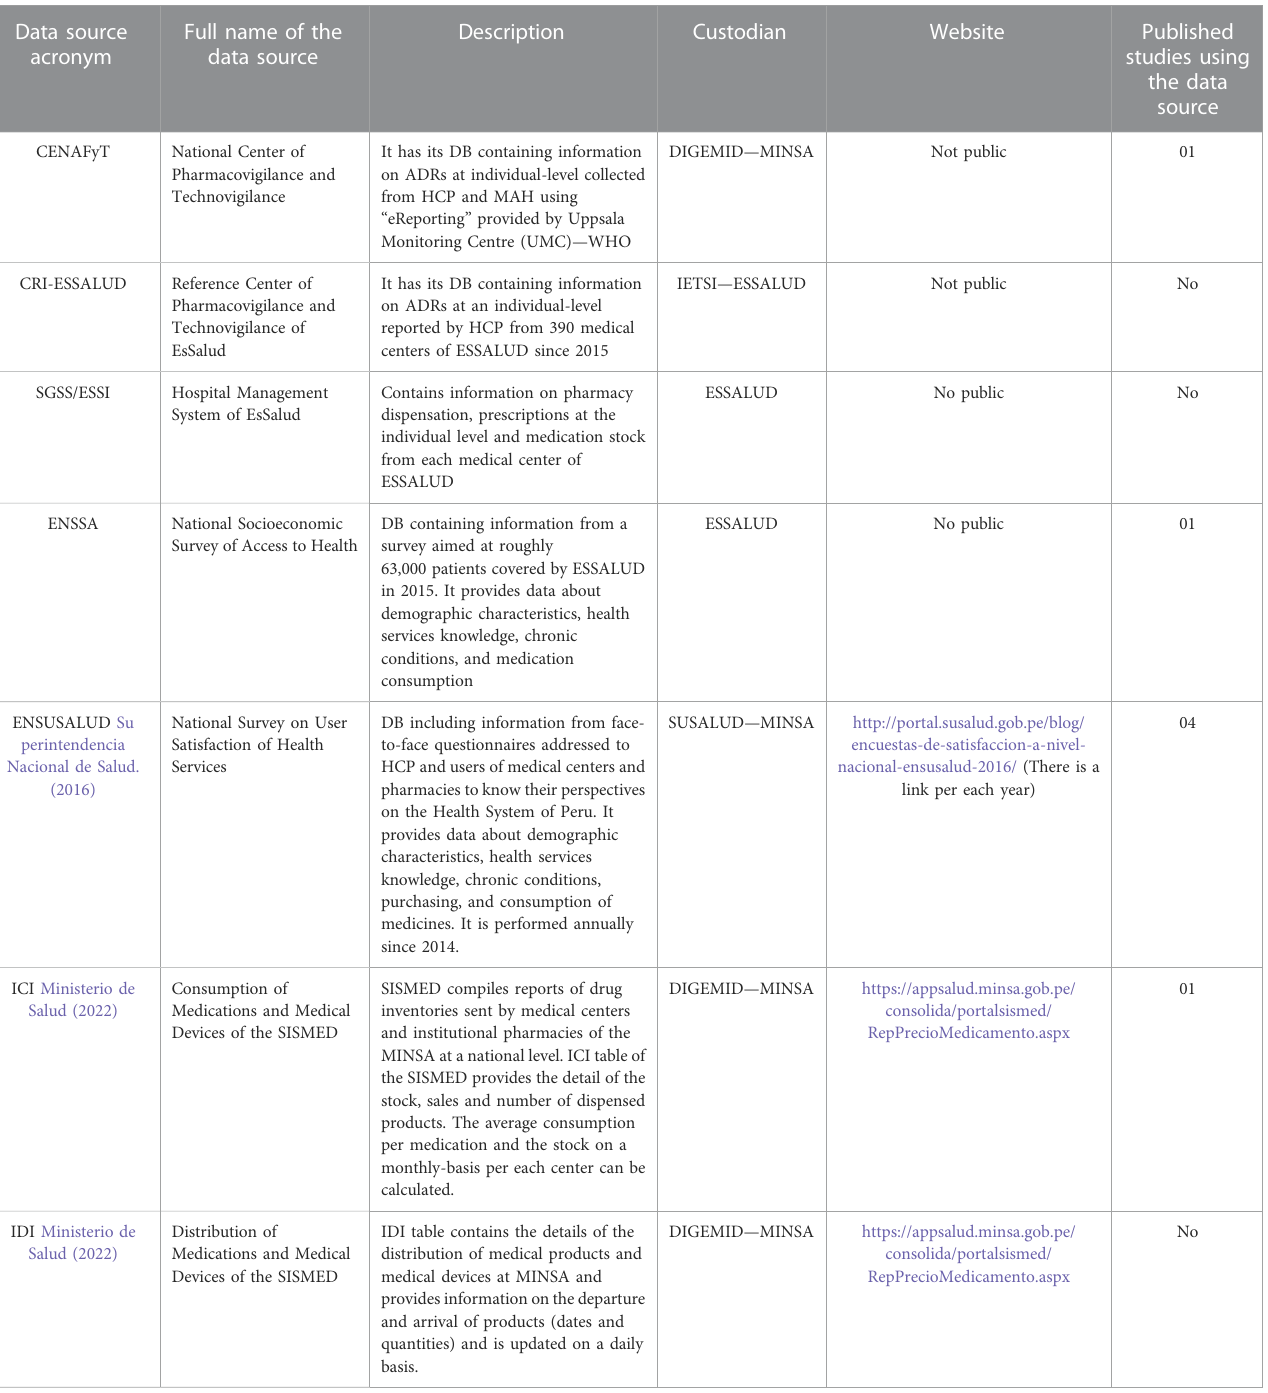
TABLE 1 General description of data sources for DUR in